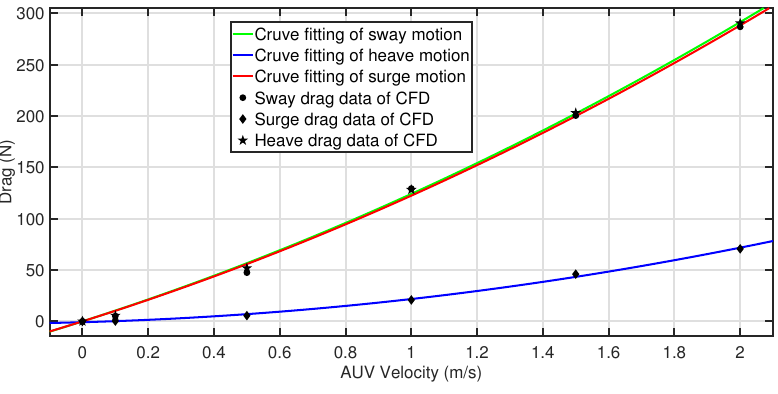
Figure 5. Fitting results.